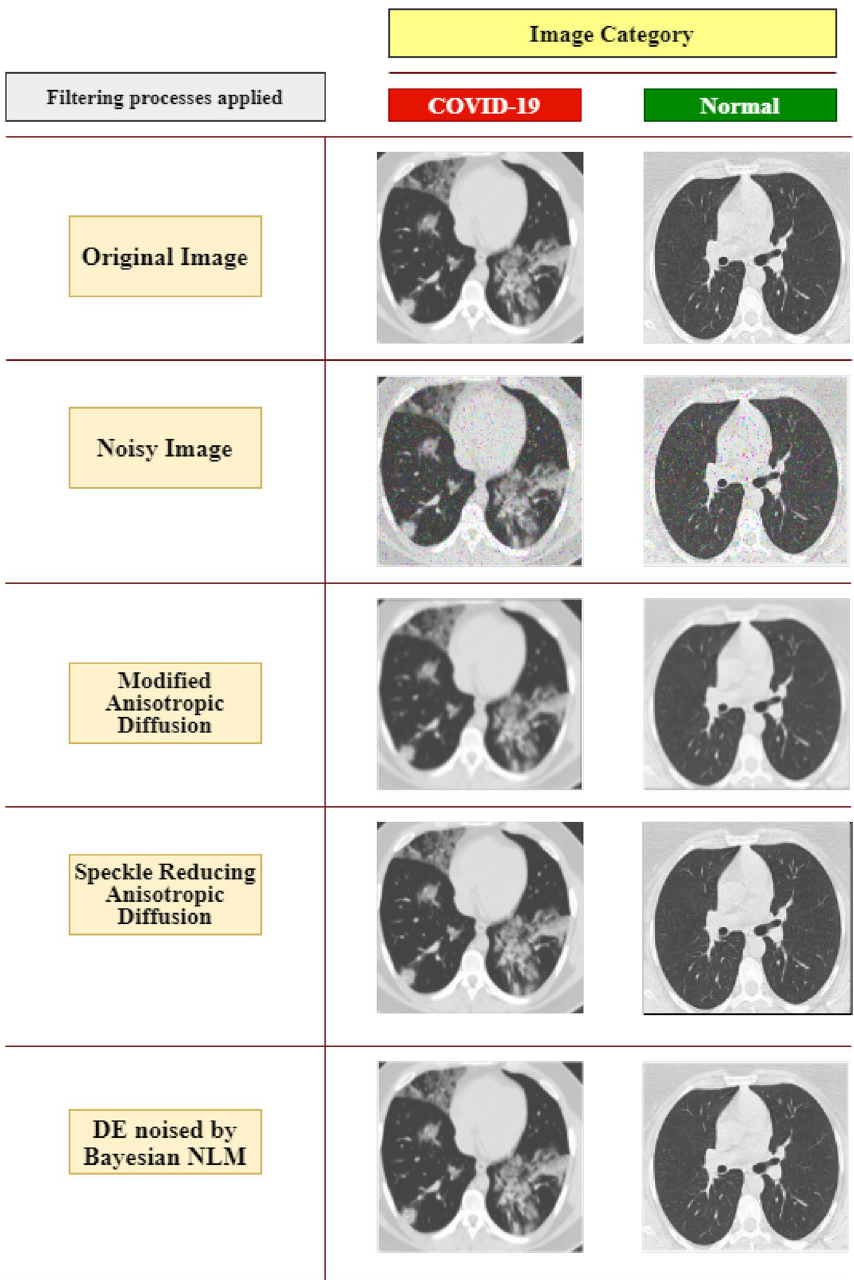
Figure 4. Category wise (COVID-19 and normal) images after different diffusion